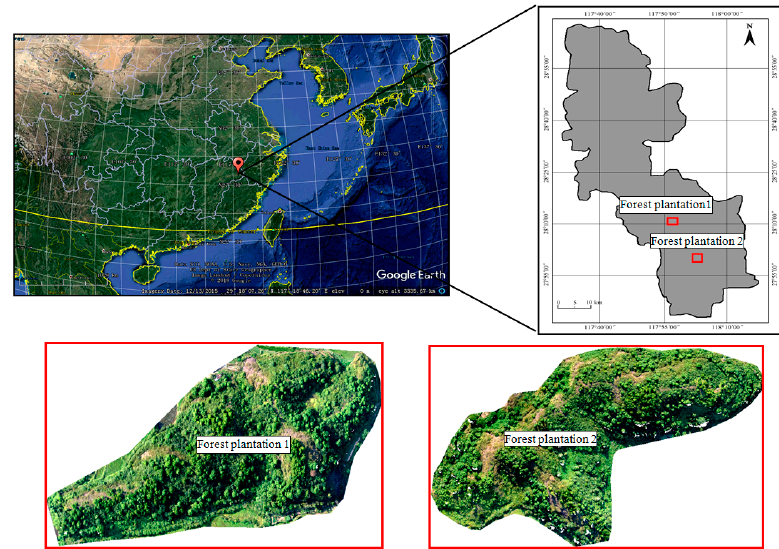
Figure 1. Two forest plantations selected from the study site in Shangrao, Southern China.